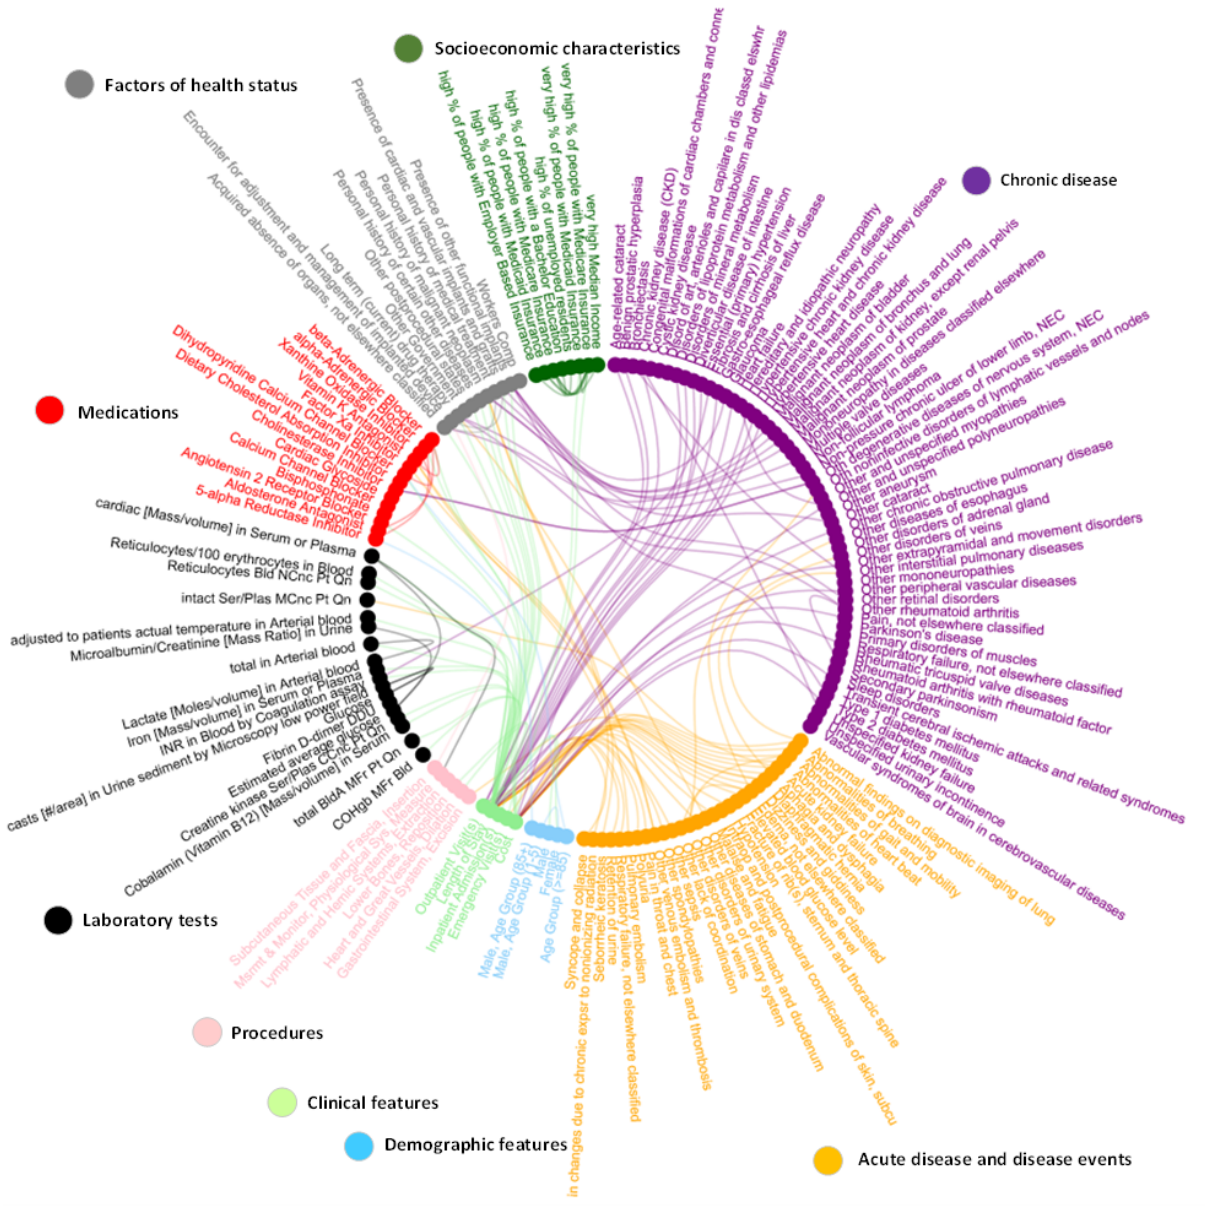
(type 2 diabetes), and hypertension. The associative relationship between arrhythmia and these chronic diseases is shown in Figure 4. Chronic kidney disease patients in later stages can have comorbidity with oliguria, anuria, or uremic cardiomyopathy, leading to uremic toxin accumulation in the body, and imbalance of homeostasis, leading to arrhythmia attack. Diabetes can cause microvascular and macrovascular complications with different pathological mechanisms, such as diabetic cardiomyopathy and diabetic kidney disease. Hypertension and chronic kidney disease are closely interlinked pathophysiologic states. Anemia is common in patients